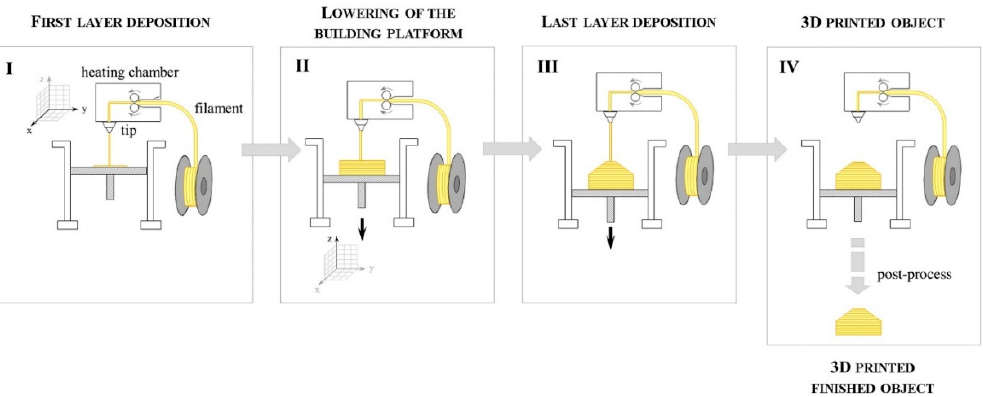
Figure 6. Outline of FDM production cycle (adapted with permission from reference [27]).